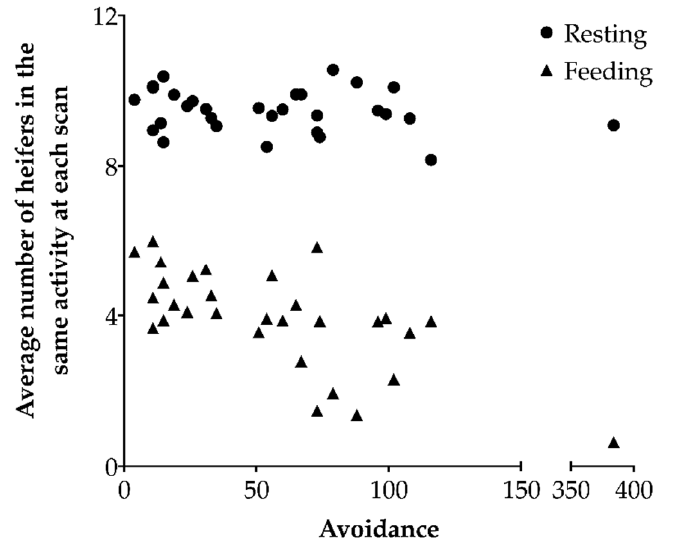
Figure 4. The relationship between each regrouped heifer’s avoidance (n = 30) and behavioral synchronization for feeding or resting. Synchronization was assessed by counting the number of individuals involved in the same activity as the regrouped heifer at each scan, and averaging over the number of scans the heifer was recorded as either feeding or resting. Agonistic behaviors were recorded continuously during the first 24 h after heifers were introduced into a new group. More avoidant heifers were less synchronized while feeding (Wald test on a linear mixed-effects model with host group as a random effect; p = 0.013), but no relationship was found with synchronization while resting ( p = 0.36). The extreme point for avoidance was capped in the model at the second highest value + 1.